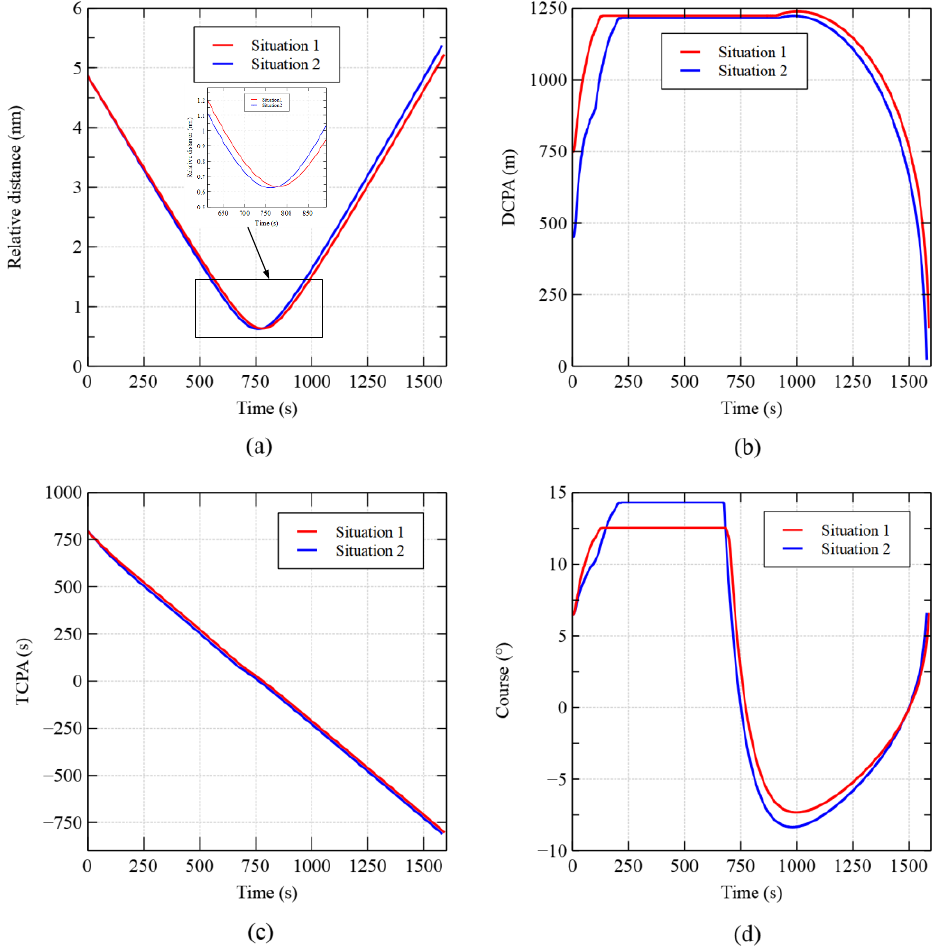
Figure 7. Real-time parameter changes under head-on situation. ( a ) Relative distance between OS and TS; ( b ) DCPA between OS and TS; ( c ) TCPA between OS and TS; ( d ) the course of OS.